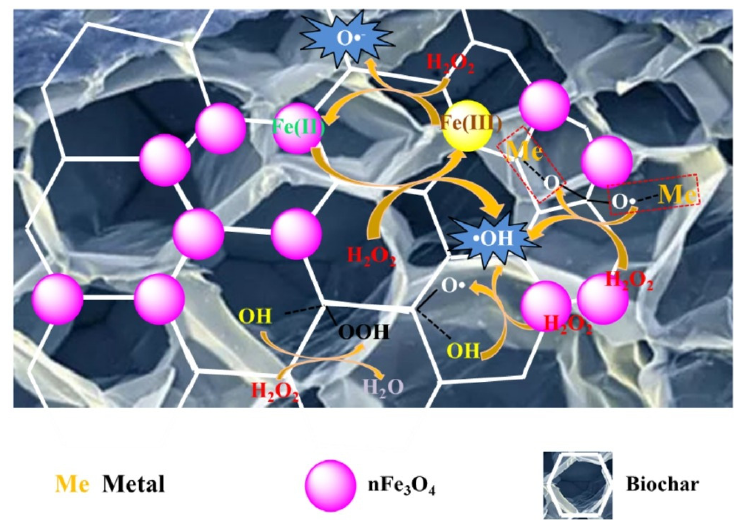
Figure 9. Proposed mechanism for ROSs generation in the nFe 3 O 4 /BC500 with activated H 2 O 2. Reprinted from Chen et al. [174] with permission from Elsevier.